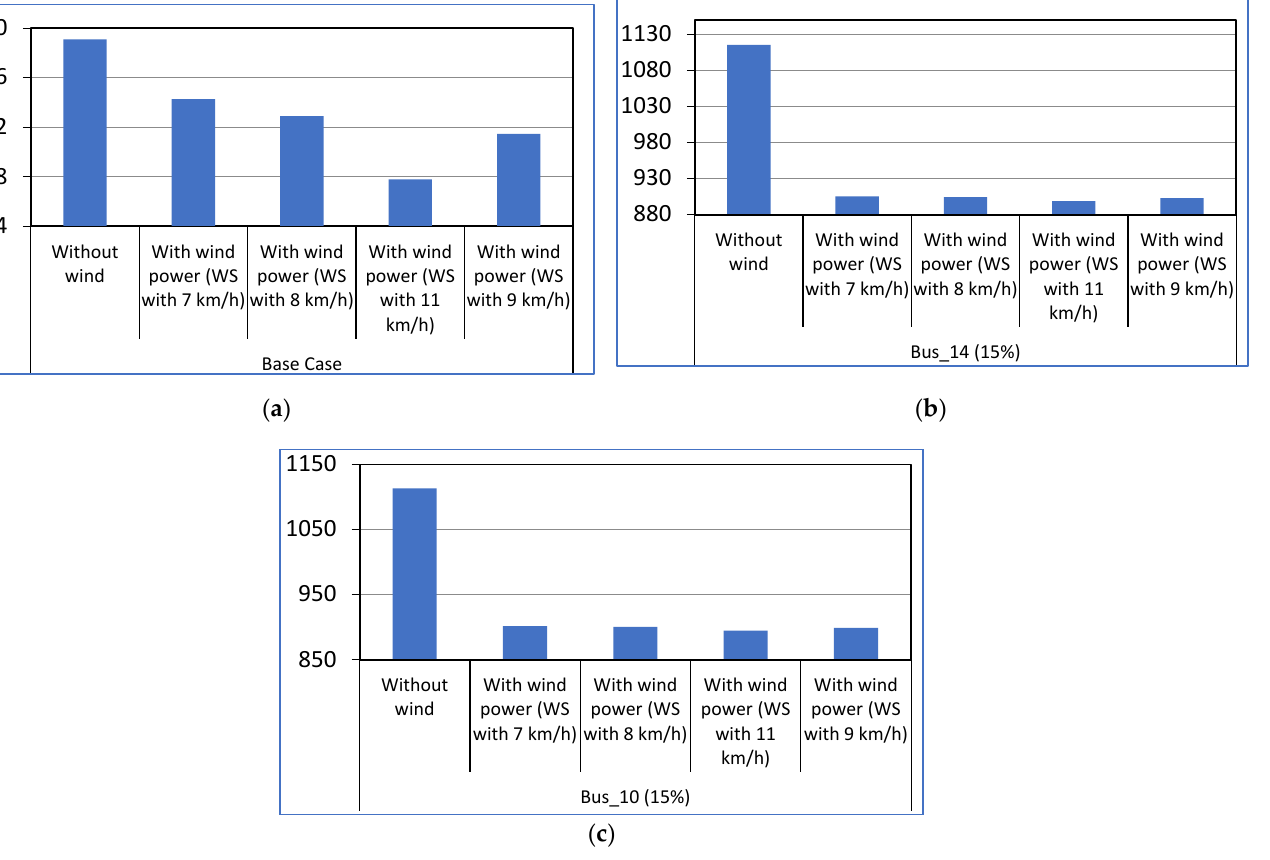
Figure 8. System Generation Cost ($/h) with Wind Power Integration (Mumbai). Base case ( a ), Bus-14 15% ( b ), Bus_10 15% ( c ).